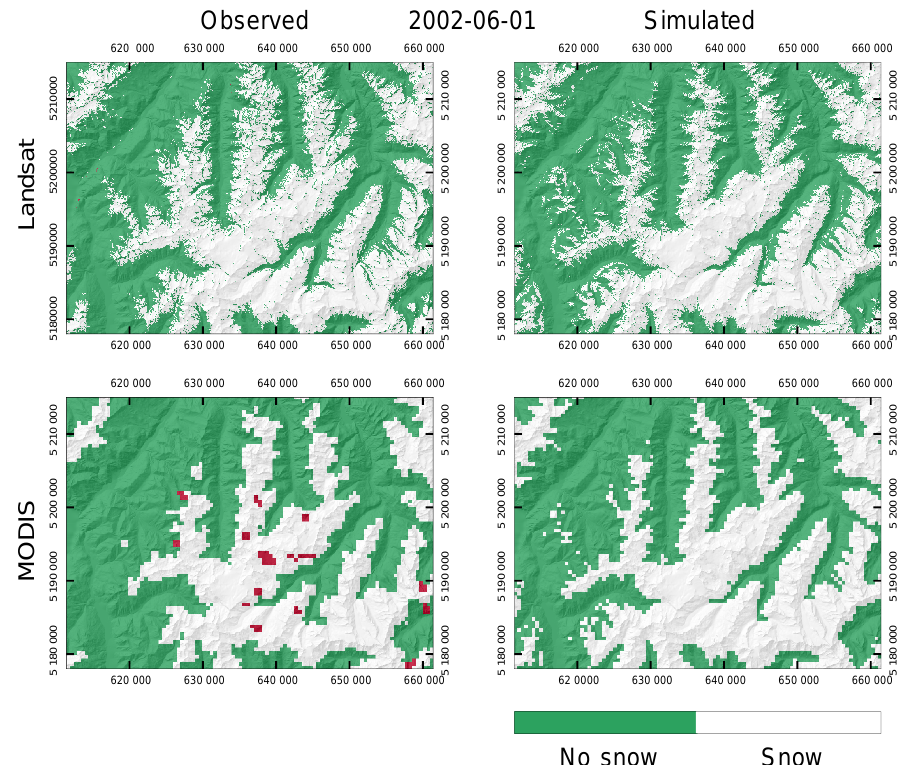
Figure 7. Observed and simulated snow cover distribution for 1 June 2002, using Landsat (top, 50m resolution) and MODIS (bottom, 500m resolution) scenes.